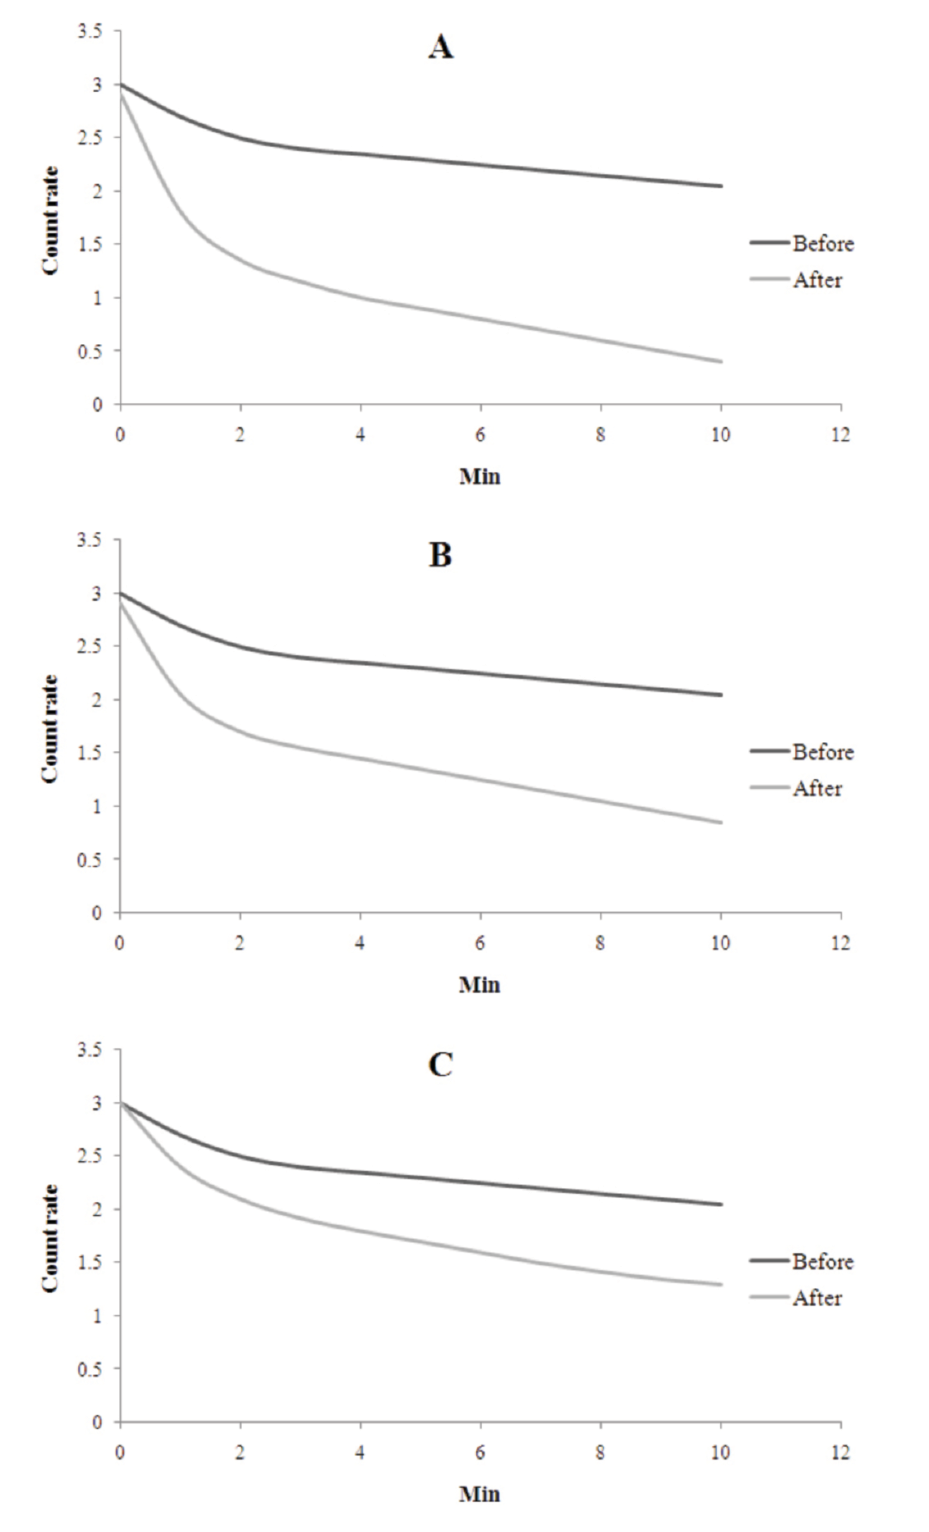
Figure 1. 133 Xe clearance curves from wound regions in the right thighs before and after administrations of vitamin E (A) and selenium (B) and in the untreated control group